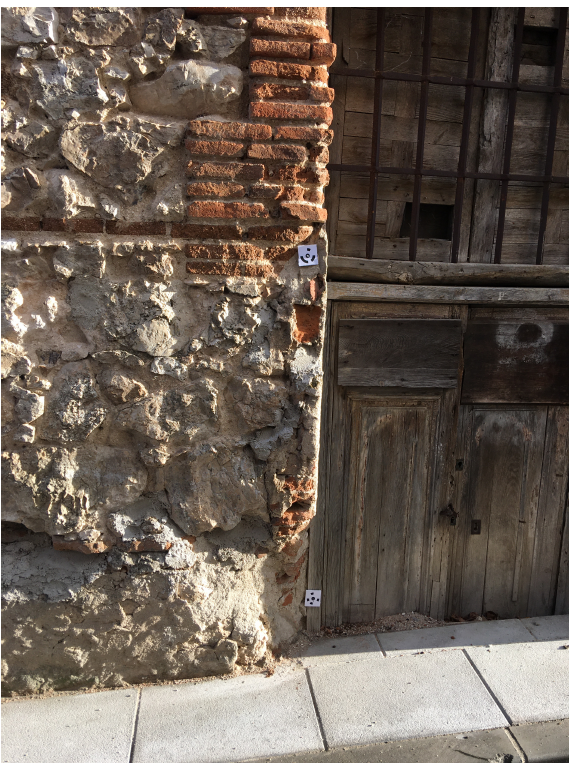
Figure 11. Example of the precision marks used.